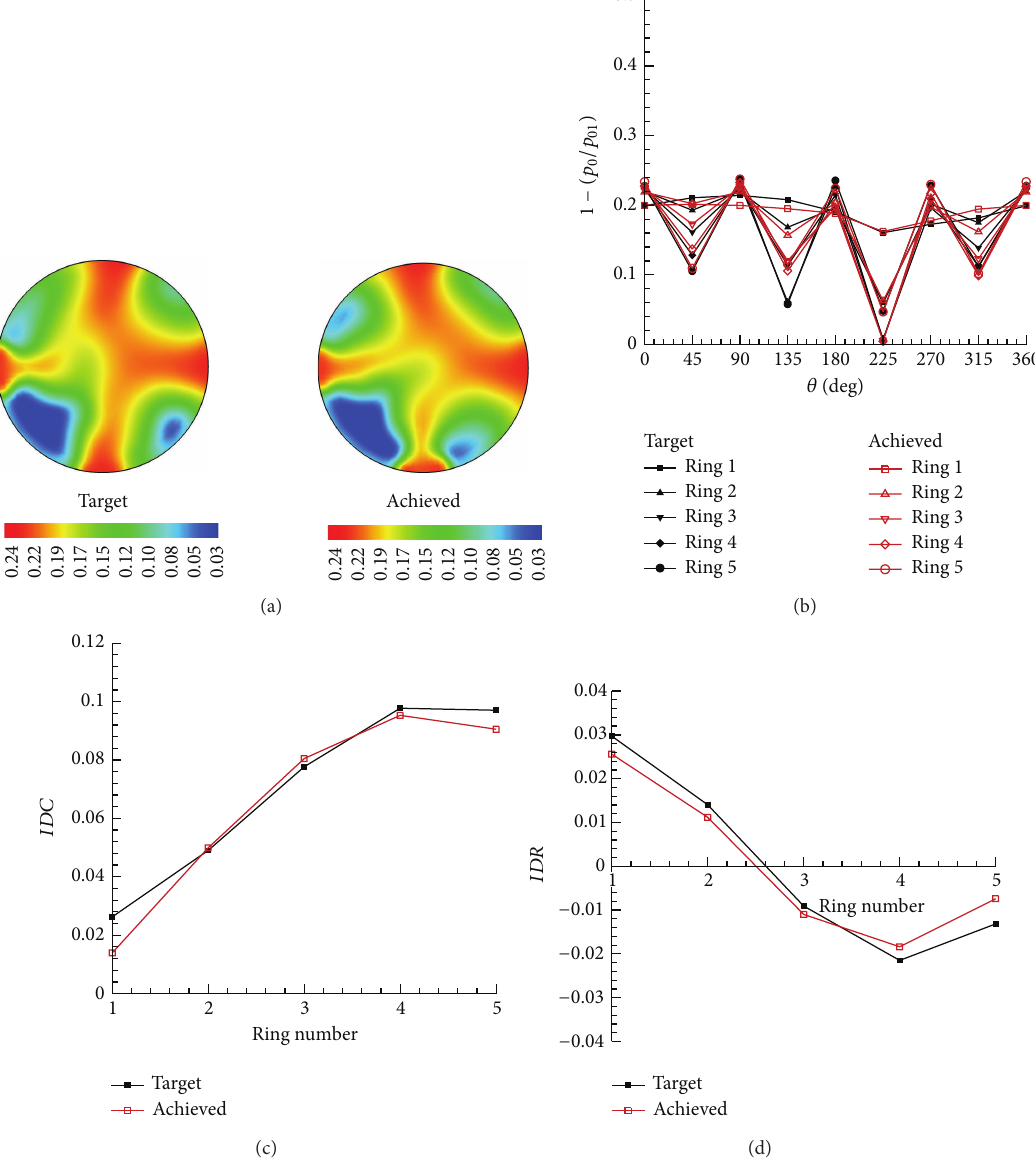
Figure 10: Distortion parameters at the AIP for Example 1. (a) Total pressure loss contours, (b) total pressure loss distribution in the rings, (c) circumferential distortion parameter IDC , and (d) radial distortion parameter IDR .